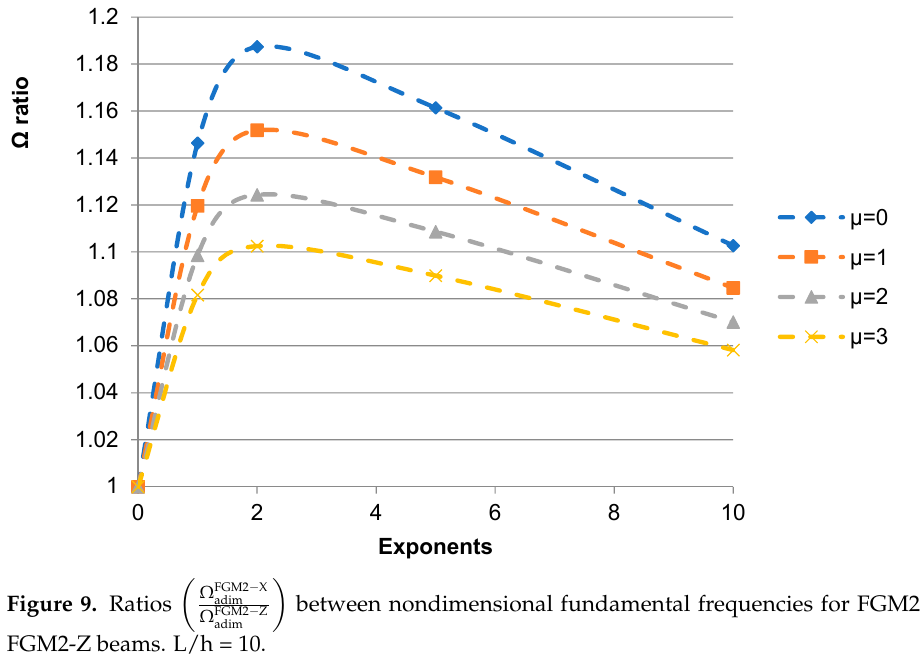
(cid:18) (cid:19) Ω FGM2 − X (cid:3159)(cid:3162)(cid:3167)(cid:3171)(cid:3138)(cid:3139)(cid:3145)(cid:3118)(cid:3127)(cid:3156) Figure 9. Ratios between nondimensional fundamental frequencies for FGM2-X and adim (cid:3440) between nondimensional fundamental frequencies for FGM2-X and Figure 9. Ratios (cid:3436) (cid:2960) Ω FGM2 − Z (cid:2960) (cid:3159)(cid:3162)(cid:3167)(cid:3171)(cid:3138)(cid:3139)(cid:3145)(cid:3118)(cid:3127)(cid:3158) adim FGM2-Z beams. L/h = 10. FGM2-Z beams. L/h =